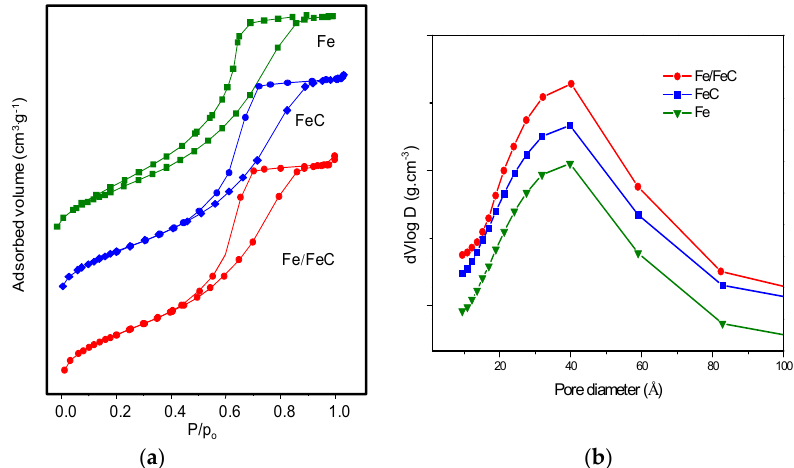
Figure 2. ( a ) Nitrogen adsorption–desorption isotherms and ( b ) pore size distribution curves of the solids studied.